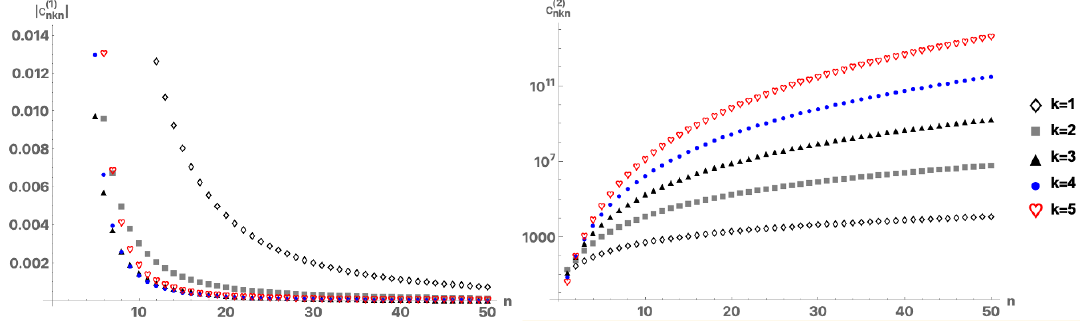
(cid:12) (cid:12) (1) (cid:12) (cid:12) (cid:12) c (cid:12) become smaller as we take the limit mkn become larger as we take the limit mkn